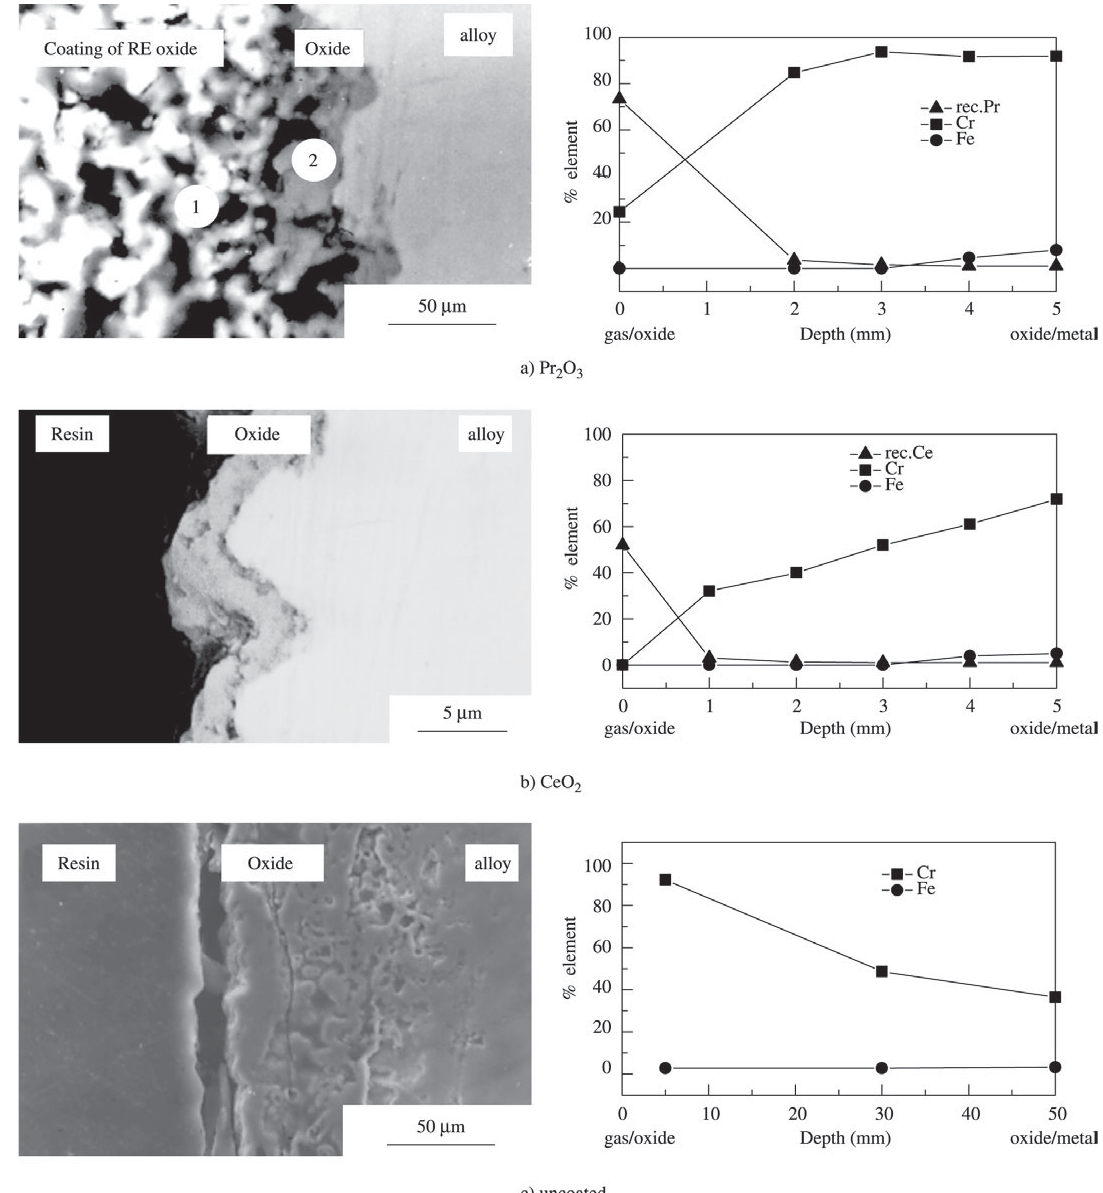
Figure 2. Cross-sectional scanning electron micrographs and the corresponding element profiles of Fe-20Cr substrates with different coatings after oxidation for 40 h at 1000